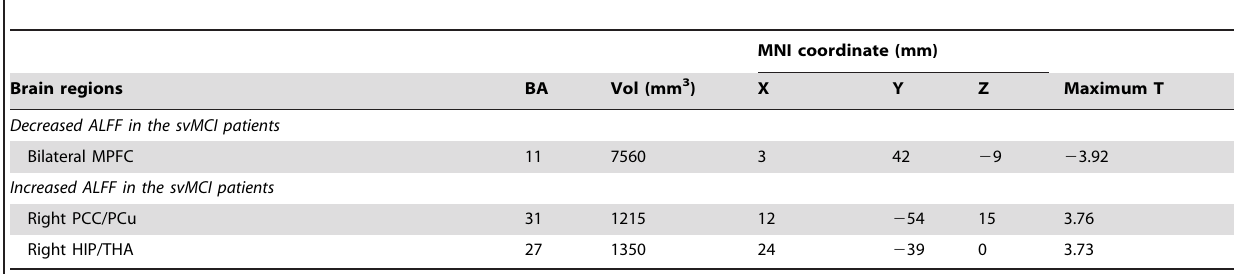
Table 3. Regions showing differences in amplitudes of LFO between the svMCI patients and healthy